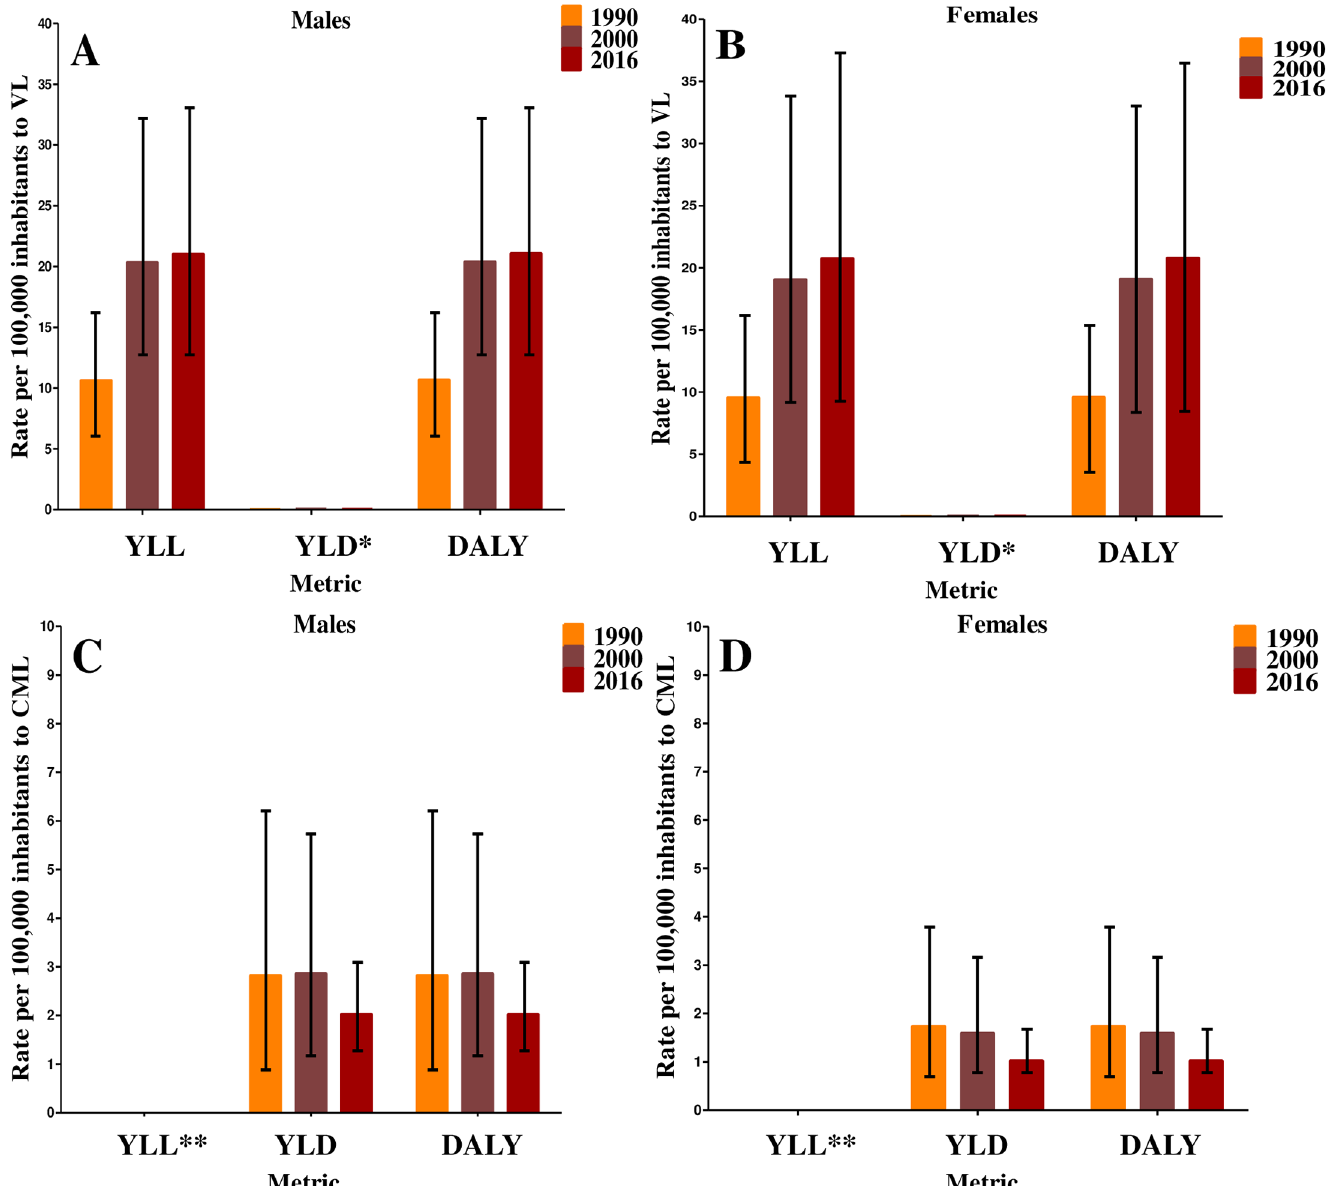
Fig 2. Age-standardized rates of years of life lost (YLL), years lived with disability (YLD), and disability-adjusted life years (DALY) per 100,000 inhabitants for Visceral Leishmaniasis (VL) and Cutaneous and Mucocutaneous Leishmaniasis (CML) in 1990, 2000, and 2016, by gender. (A) Rates per 100,000 inhabitants for males with VL. (B) Rates per 100,000 inhabitants for females with VL. (C) Rates per 100,000 inhabitants for males with CML. (D) Rates per 100,000 inhabitants for females with CML. (cid:3) Visceral Leishmaniasis values of YLD are less than one. (cid:3)(cid:3) Cutaneous and Mucocutaneous Leishmaniasis mortality was assumed to be zero and for this reason YLL values are zero. GBD Study